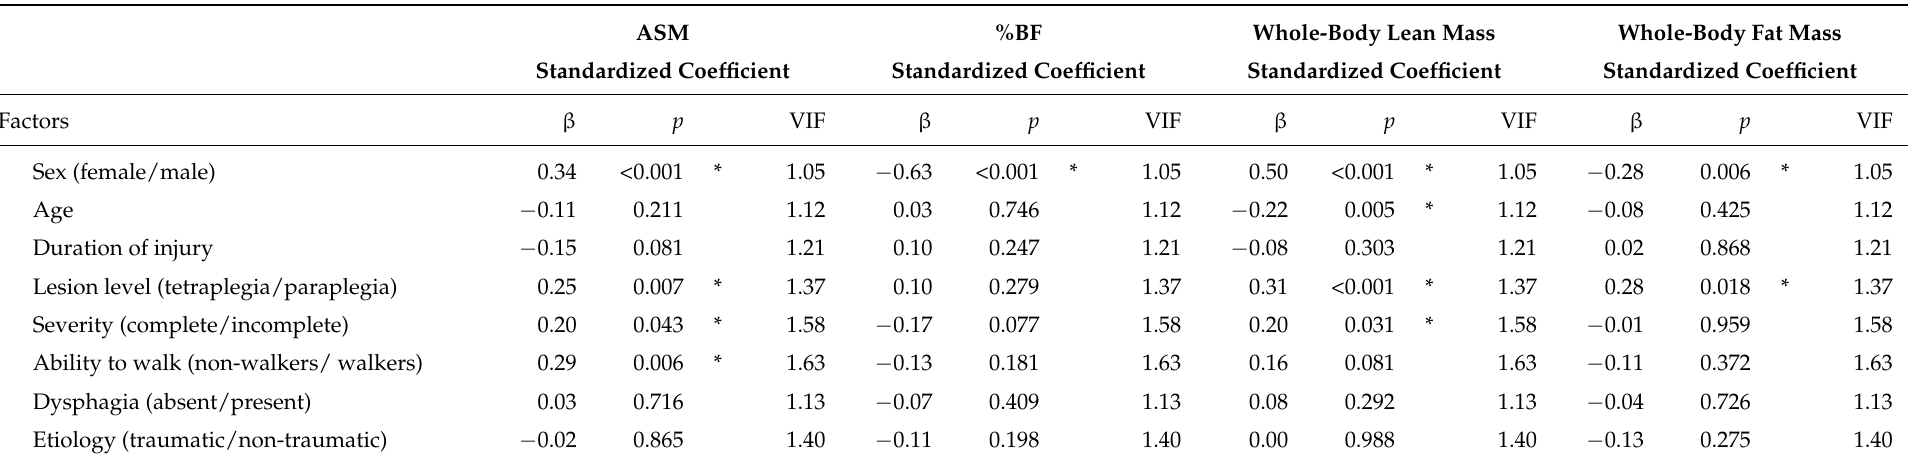
Table 5. Multivariate linear regression analysis of DXA-measured sarcopenia and obesity-related outcomes.